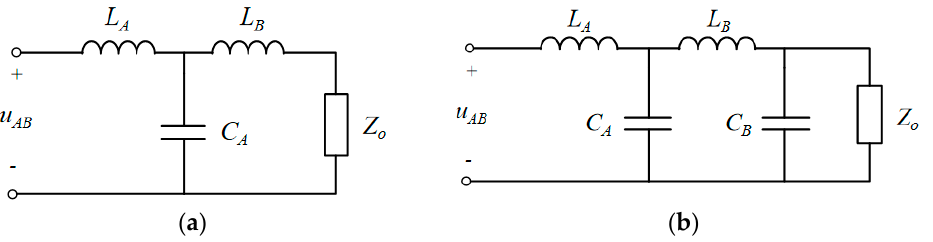
Figure 6. Compensation networks: ( a ) LCL, ( b ) dual resonant frequency network.